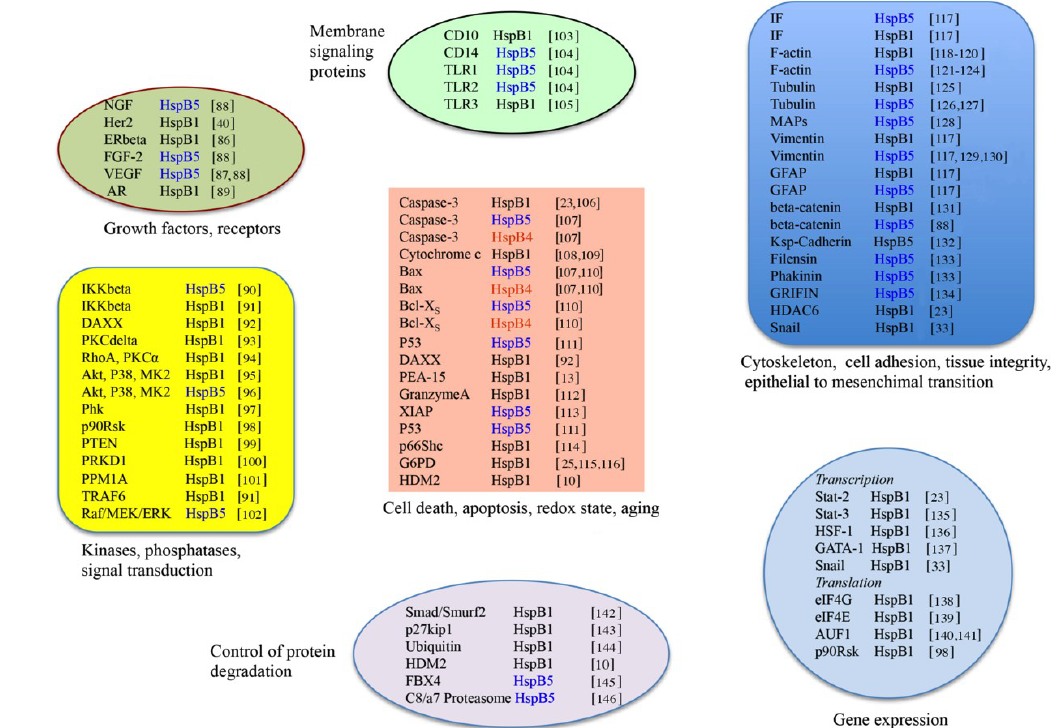
Figure 1. HspB1, HspB5 and HspB4 client proteins and tumor cell growth. The client proteins are listed in function of their tumor-prone